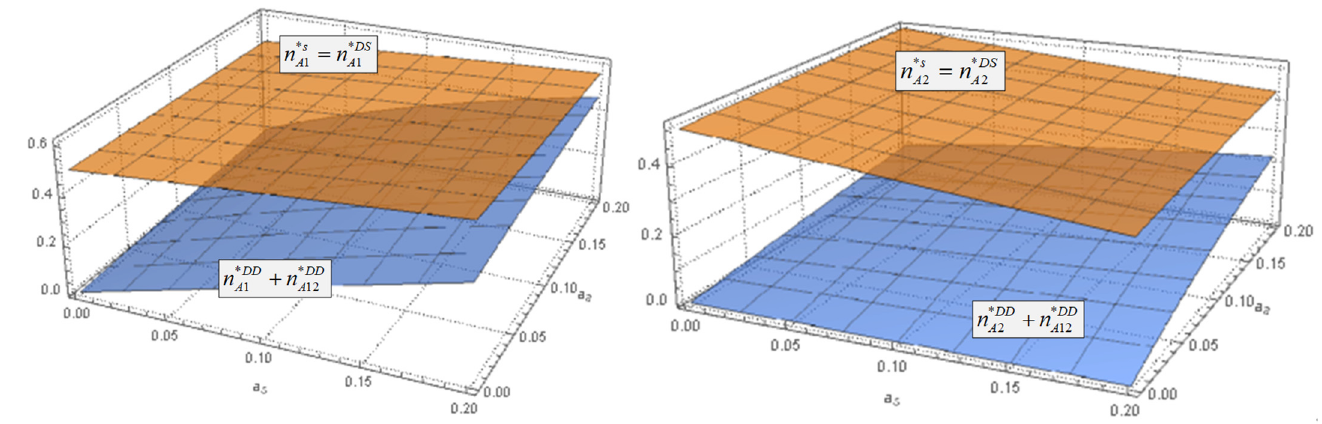
Figure 6. The impacts of network effect on the number of advertisers in three cases.